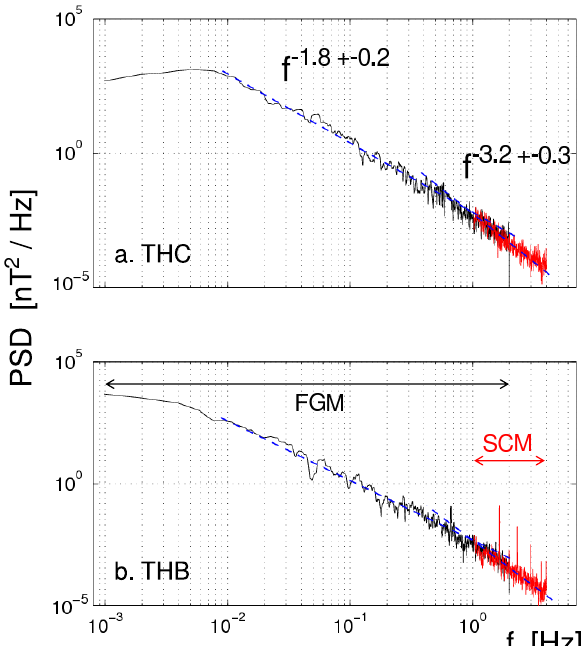
Fig. 5. Power spectral density (PSD) plots; (a) THC probe; (b) THB probe; FGM and SCM magnetic instruments data are